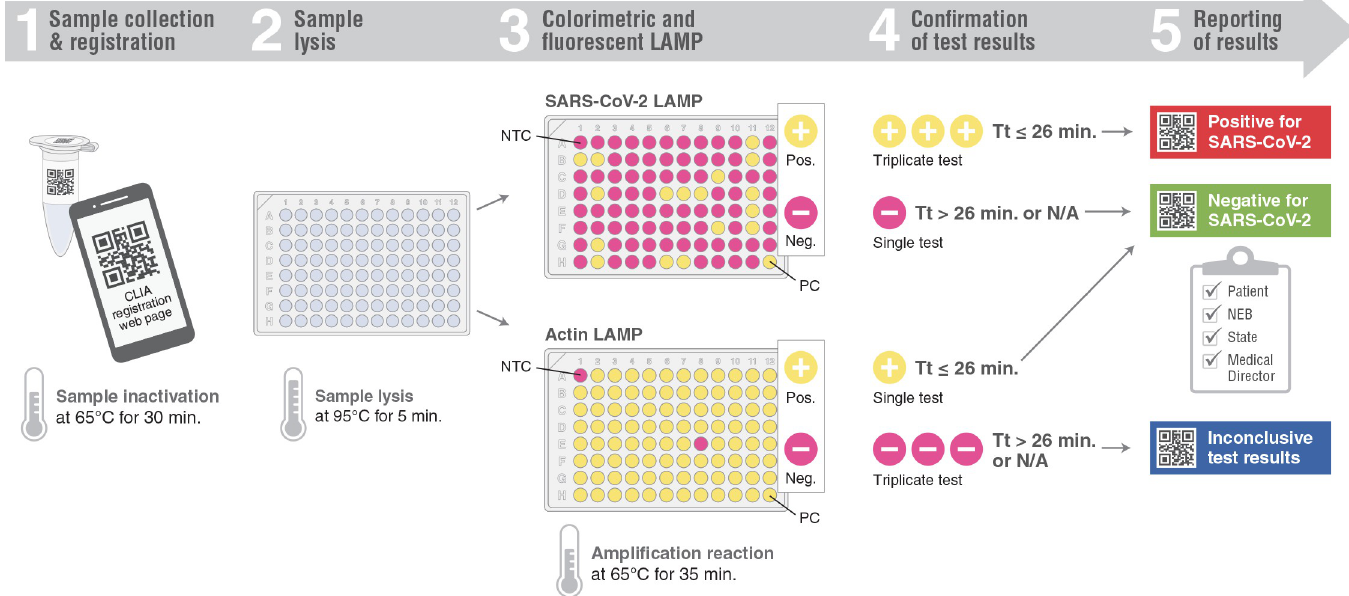
Fig 5. Diagrammatic representation of the extraction-free saliva SARS-CoV-2 RT-LAMP workflow. The process from specimen collection, sample lysis, RT-LAMP testing and result reporting are shown.